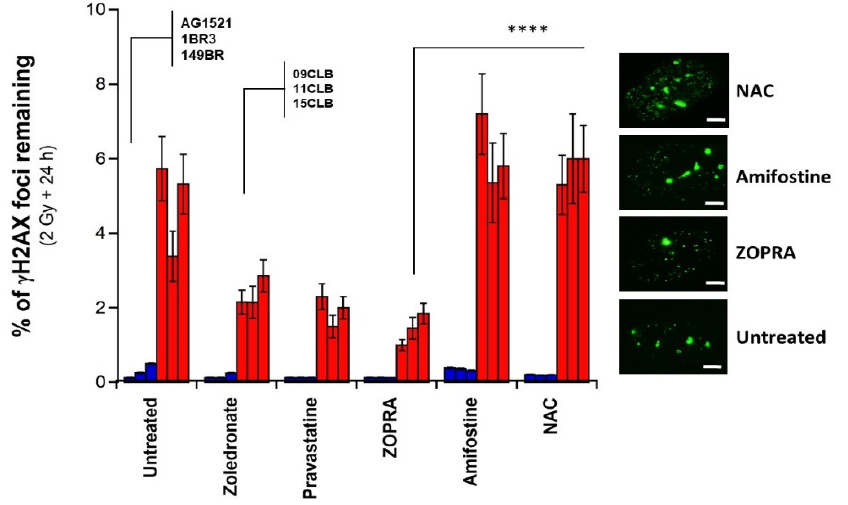
Figure 5. Relative radioprotective effect of a pretreatment with zoledronate, pravastatine, ZOPRA, NAC and amifostine. The data shown in Figure 3C are expressed as percentage of γ H2AX foci remaining, calculated by dividing the number of γ H2AX foci assessed 24 h post irradiation (Figure 4C) by the number of γ H2AX foci assessed 10 min post irradiation (Figure 4B). Inserts show representative examples of untreated and ZOPRA, 300 mM amifostine and 96 mM NAC pretreated 09CLB nuclei with γ H2AX foci assessed at the indicated conditions. White bar represents 5 µ m. Four asterisks indicate p < 0.0001, respectively, between ZOPRA data and NAC and amifostine data.